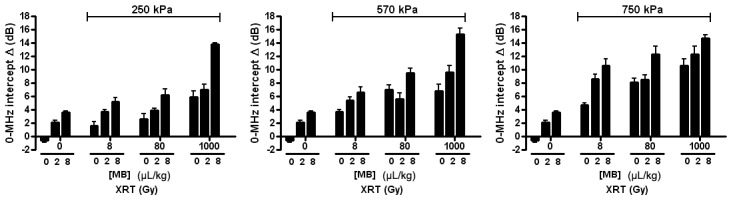
Average changes in 0-MHz intercept parameter.Each bar represents the mean of 0-MHz intercept values of five mouse-borne tumors (n = 5). The error bar indicates the standard error within the sample size. Statistical testing using 2-way ANOVA indicates the effects caused by the changes in both microbubble concentration and dose of radiation to be very significant for every graph (p<0.0001). Each graph shows the average changes in 0-MHz intercept for varied microbubble concentration and radiation doses at a fixed ultrasound pressure: 250 kPa, 570 kPa, and 750 kPa.